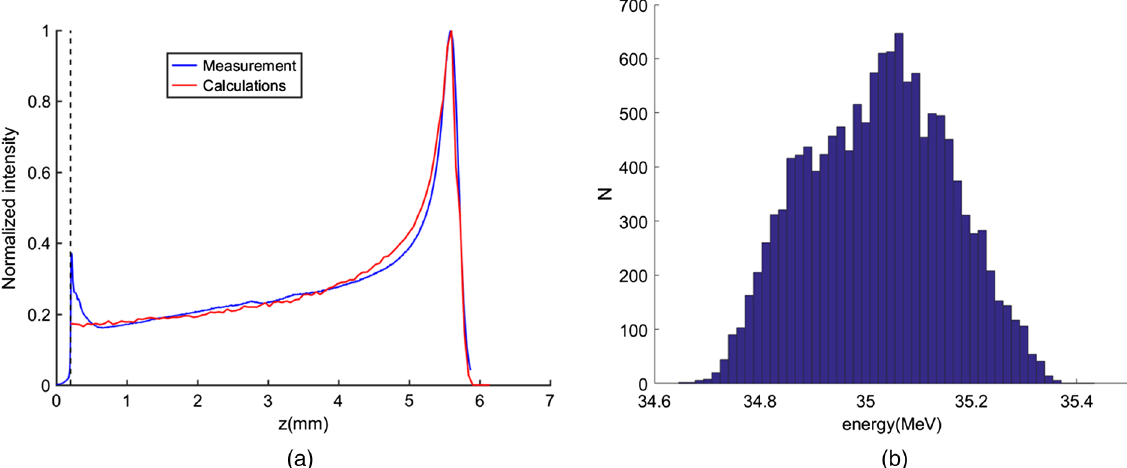
FIG. 20. (a) Comparison between the measured PL intensity profile versus depth and the computed energy loss profile in the LiF detector. The dotted line indicates the crystal edge. (b) Computed beam energy distribution of the accelerated beam before the exit window.